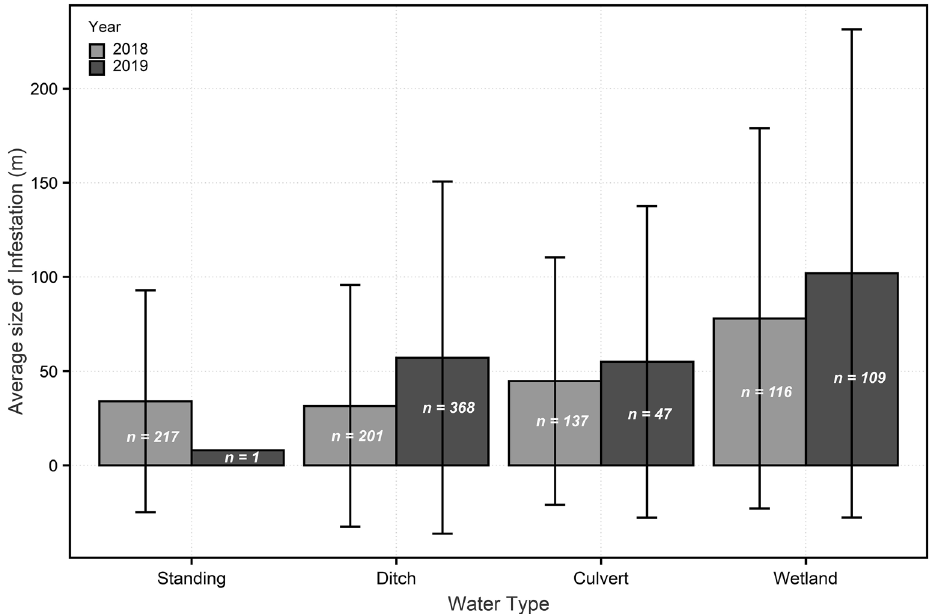
Figure 1. Size of infestations by water